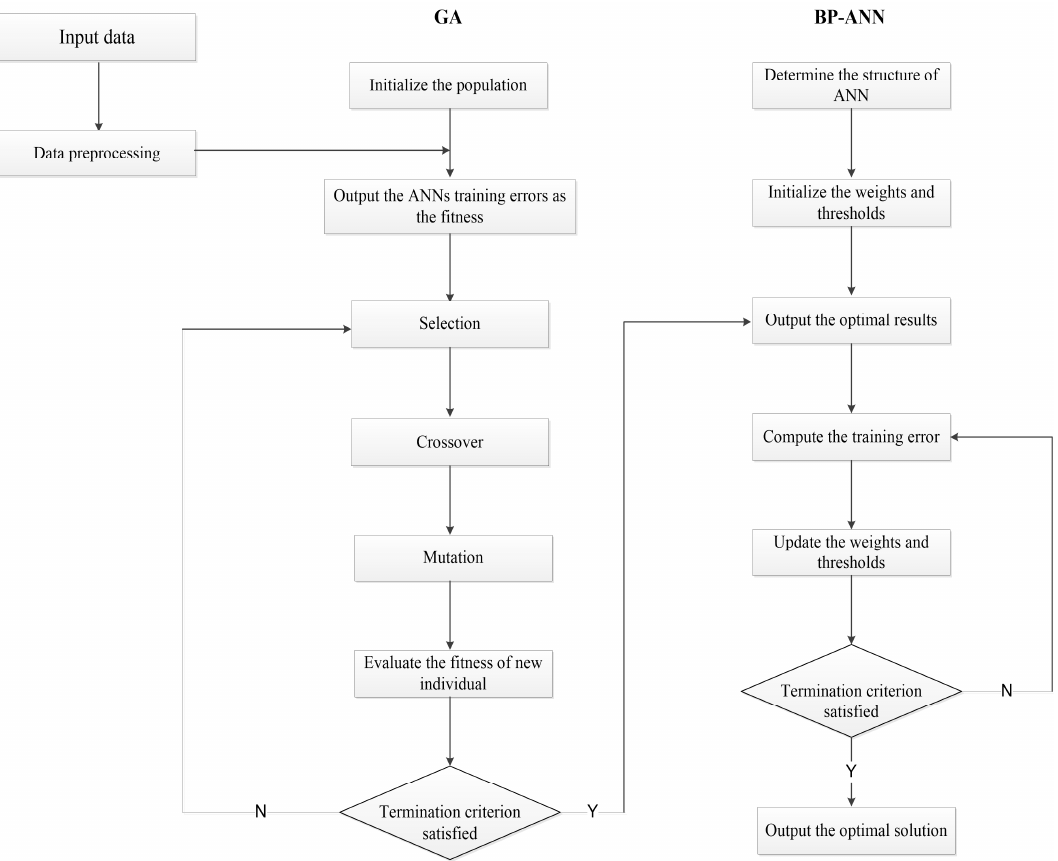
Figure 3. The flowchart of the artificial neural network (ANN) optimized by the genetic algorithm In the study, the input parameters of the neural network consisted of day of year (DOY), universal time (UT), geomagnetic latitude (GLAT) and geographic longitude (LON). In addition, ionospheric variation is affected by solar-geomagnetic activity seriously, the parameters represent solar-terrestrial environment were also as the inputs. The parameters SSN (sunspot number), Vsw (solar wind speed) and F107 (10.7cm solar flux) were used to represent the intensity of solar radiation. The values Dst, Kp and Ap were selected to represent geomagnetic environment. Our study found that the neutral wind did not play a great role in improving the accuracy of the ANN model; hence, the meridional wind and zonal wind were not used as the input parameters. This ANN structure contained three hidden layers in the study, and the network was trained for more than thousands of times to search for the optimal simulated results. The RMSE of this ANN was minimum when the numbers of nodes in each hidden layer were 16, 14 and 12, respectively, and the corresponding active functions in these hidden layers were tansig, tansig and sigmoid. The architecture of the ANN is shown in Figure 2. After the input parameters and the structure of ANN model were determined, the entire “mixed” corrected measurements were used to develop the ANN-based ionospheric models wholly. In the study, the input parameters, model’s structure and modeling strategy were different from the ANNIM model in literature